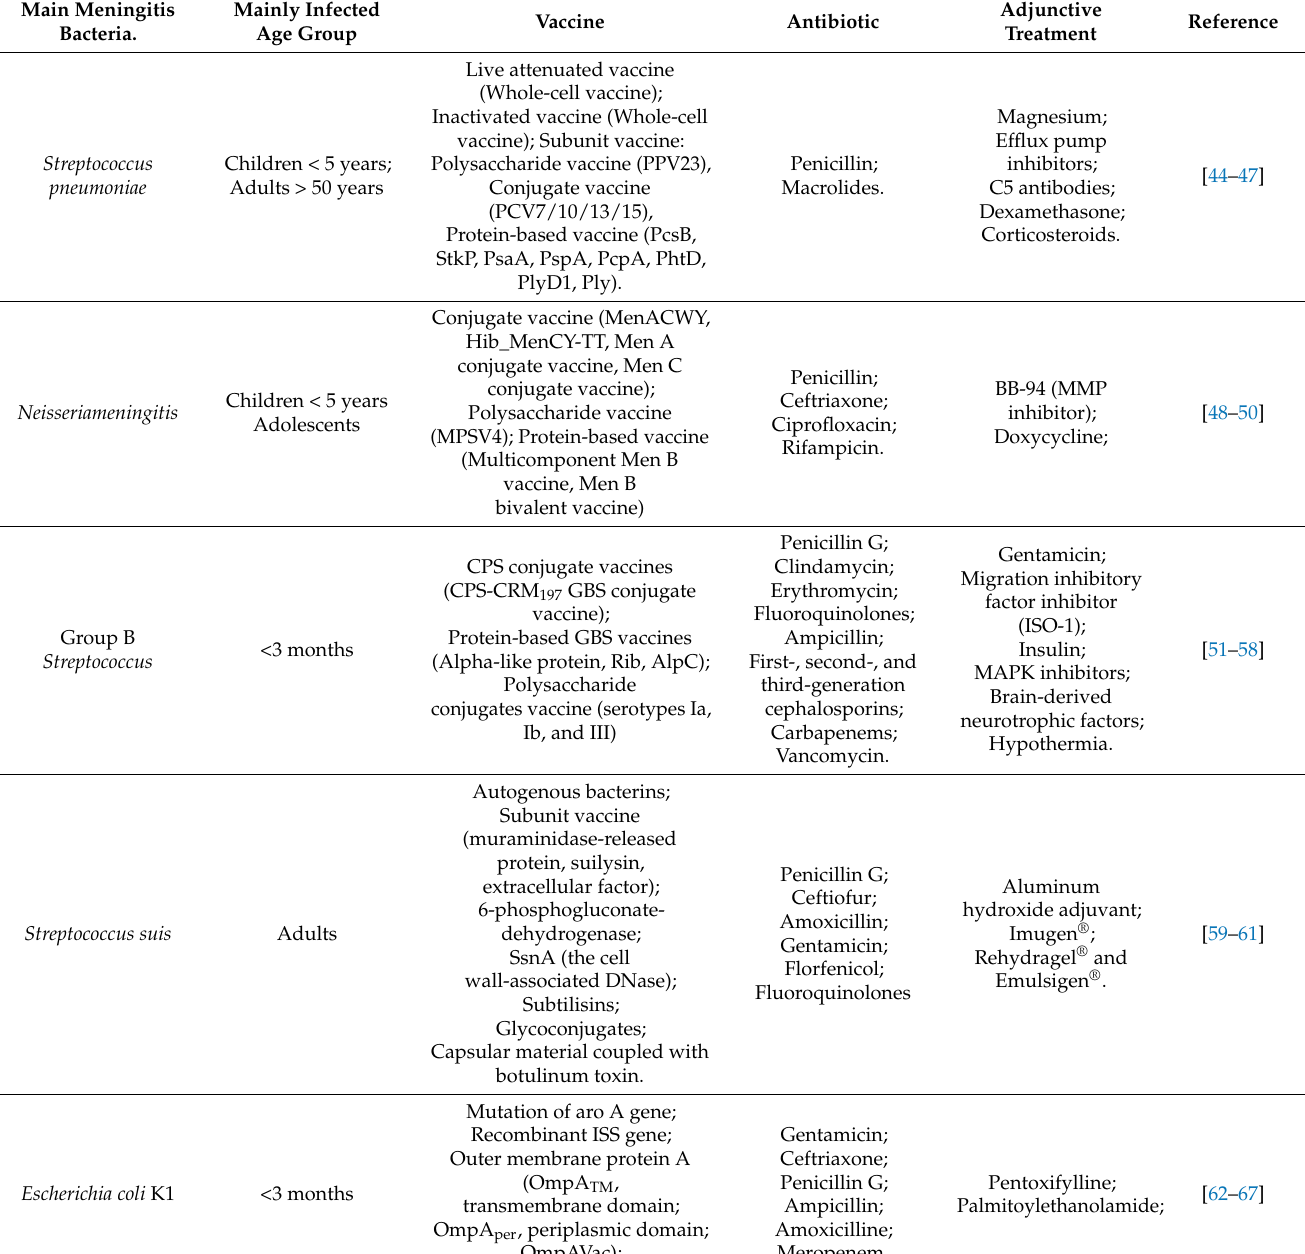
Table 1. The treatments of bacterial